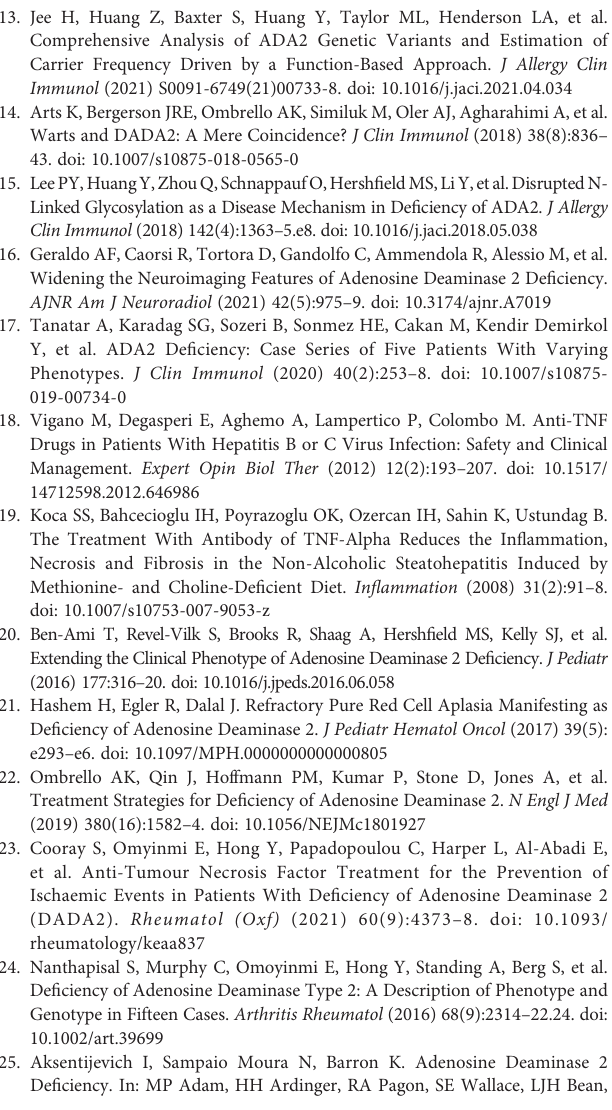
Supplementary Table 2 | Comprehensive immune phenotyping of DADA2